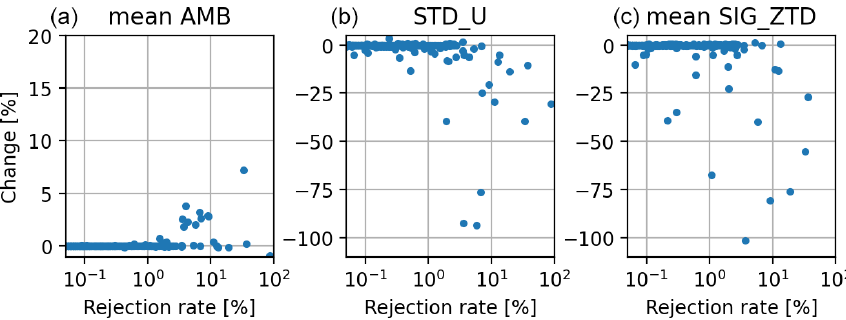
Figure 2. Percentage change in mean ambiguity resolution rate (mean AMB, a ), repeatability on height (STD_U, b ), mean ZTD formal error (SIG_ZTD, c ) induced by the data screening method, versus the data rejection rate for each of the 1221 GNSS stations.